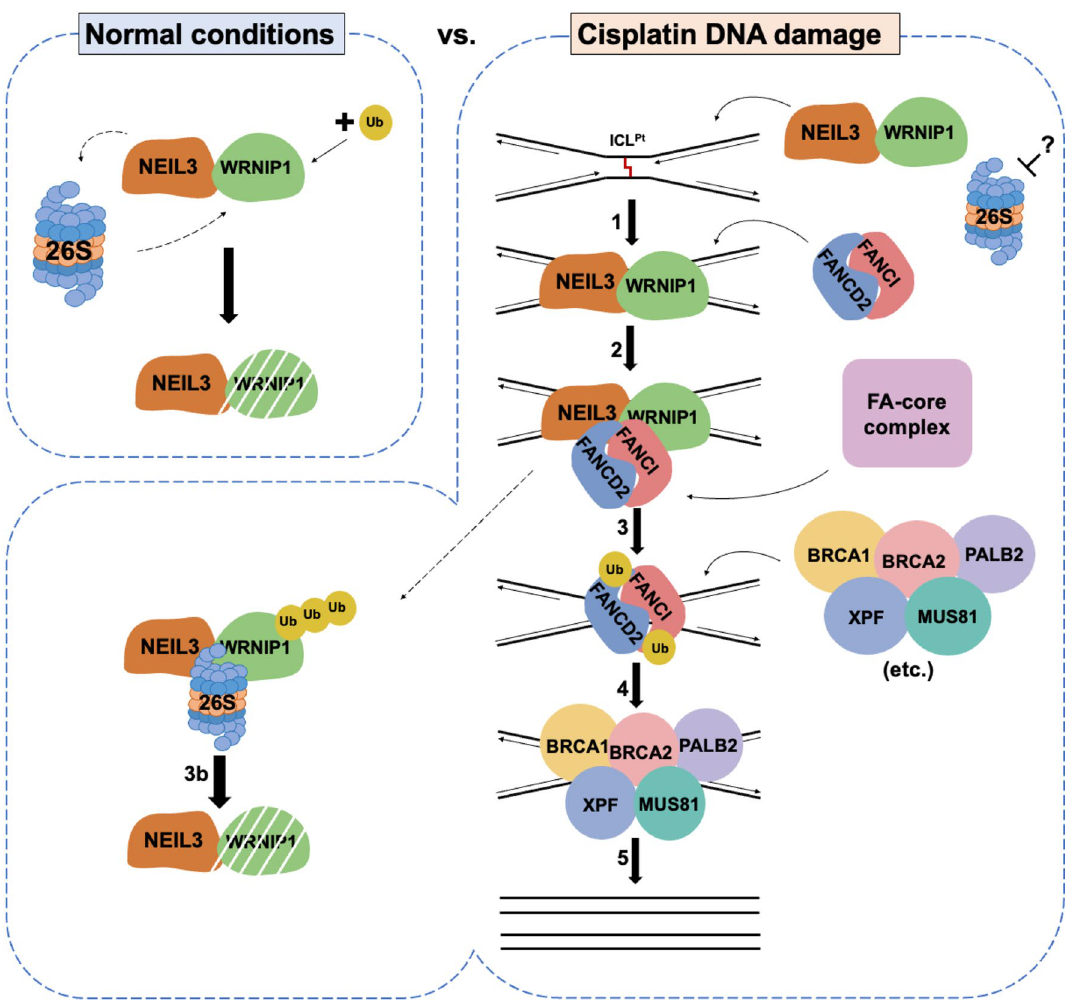
Figure 5. A model of the NEIL3-dependent proteasomal degradation of the WRNIP1 protein upon cisplatin- induced